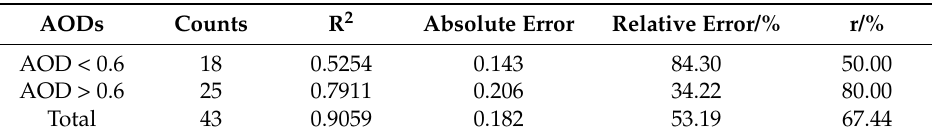
Table 5. Validation of retrieved AOD.